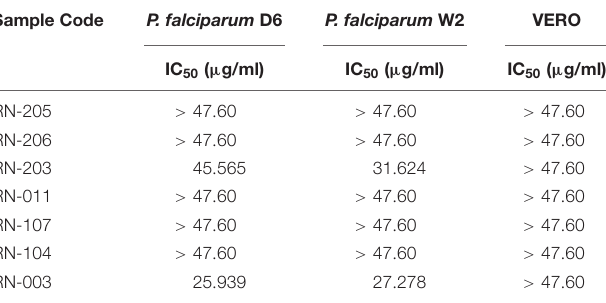
TABLE 5 | Antimalarial assays of the EtOAc extracts of the isolated microorganisms showing that metabolites from Bacillus safensis RN-003 exhibited moderate antiplasmodial activity and that from Bacillus anthracis RN-203 showed weak activity.